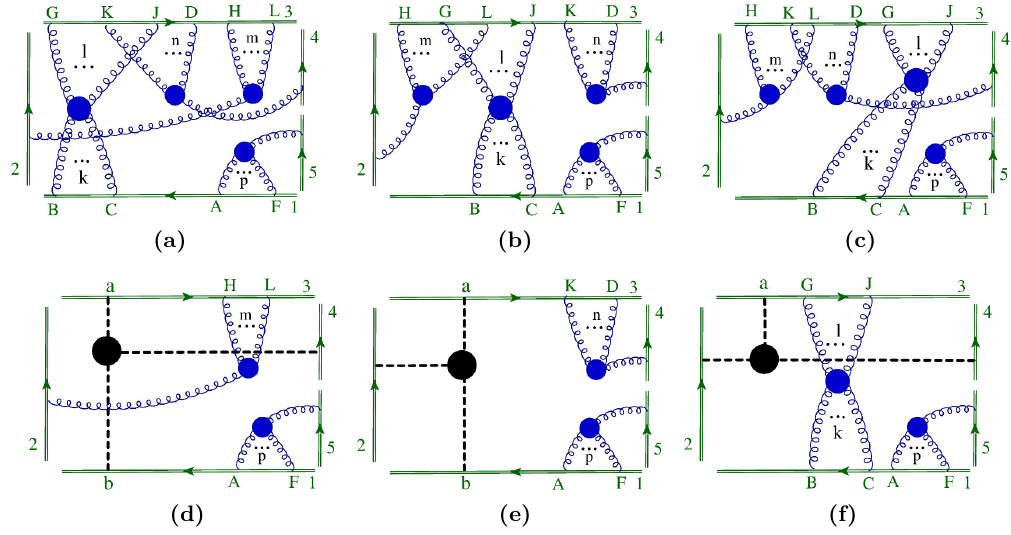
(1 , 1 , 1 , k + p, m + l + n ) . 5